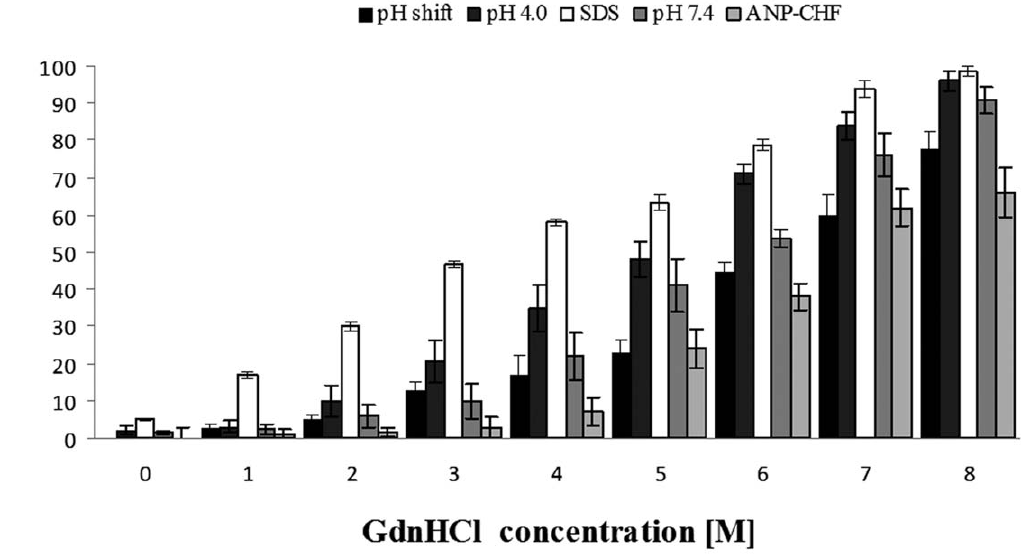
Figure 7. Stability of ANP aggregates via GdnHCl addition. ANP-CHF fibrils were the most resistant since only above 4 M GdnHCl, an increasingly greater percent of total fibrils was resolubilized.